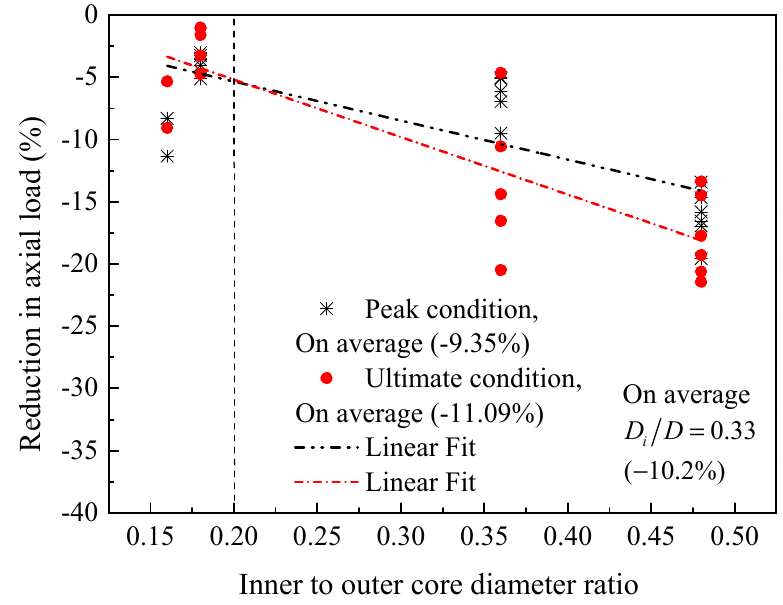
Figure 26. Relationship between varying D i / D ratios and reduction in peak loads.